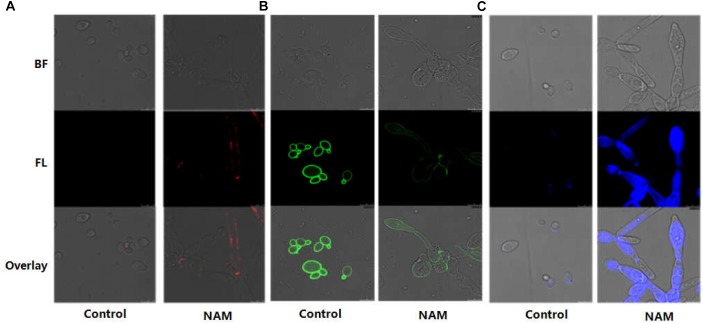
Effect of NAM on cell wall organization. C. albicans cells were treated with 20 mM of NAM for 16 h and then stained with β-glucan antibody to detect β-(1,3)-glucan (A) Concanavalin-A to detect mannan (B) and calcofluor white to detect chitin (C). Bright field (BF), fluorescence (FL), and overlay were shown individually.